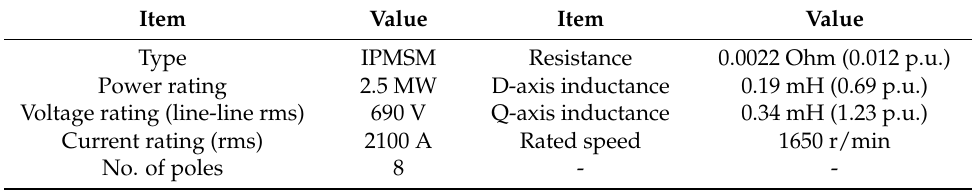
Table 3. 2.5 MW class motor simulation